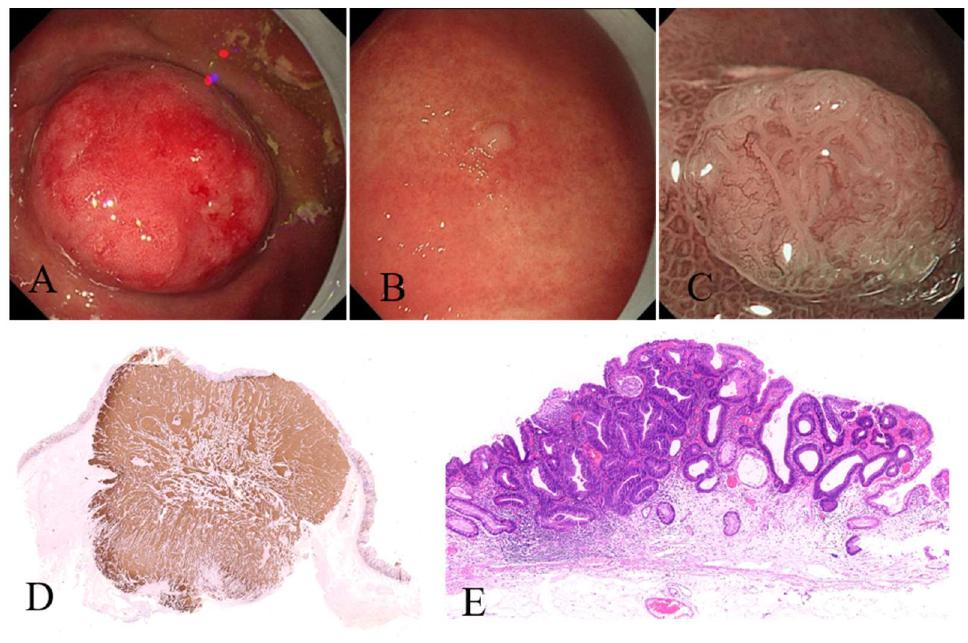
Figure 5. Adenocarcinoma and type-1 gNET arising from the background of AMAG. ( A ) Protruding lesion in the upper corpus, ( B ) white nodule in the lower corpus, ( C ) ME-NBI observation of the nodule showing clear demarcation line with irregular microvessels and microstructure on the surface, ( D ) immunohistochemical stain for Synaptophysin in the protruding lesion (×4), ( E ) HE stain of the white nodule in the lower corpus showing early well-differentiated adenocarcinoma (×4). Case 2: A 70-year-old female patient who presented as anemic for 2 years was diag-